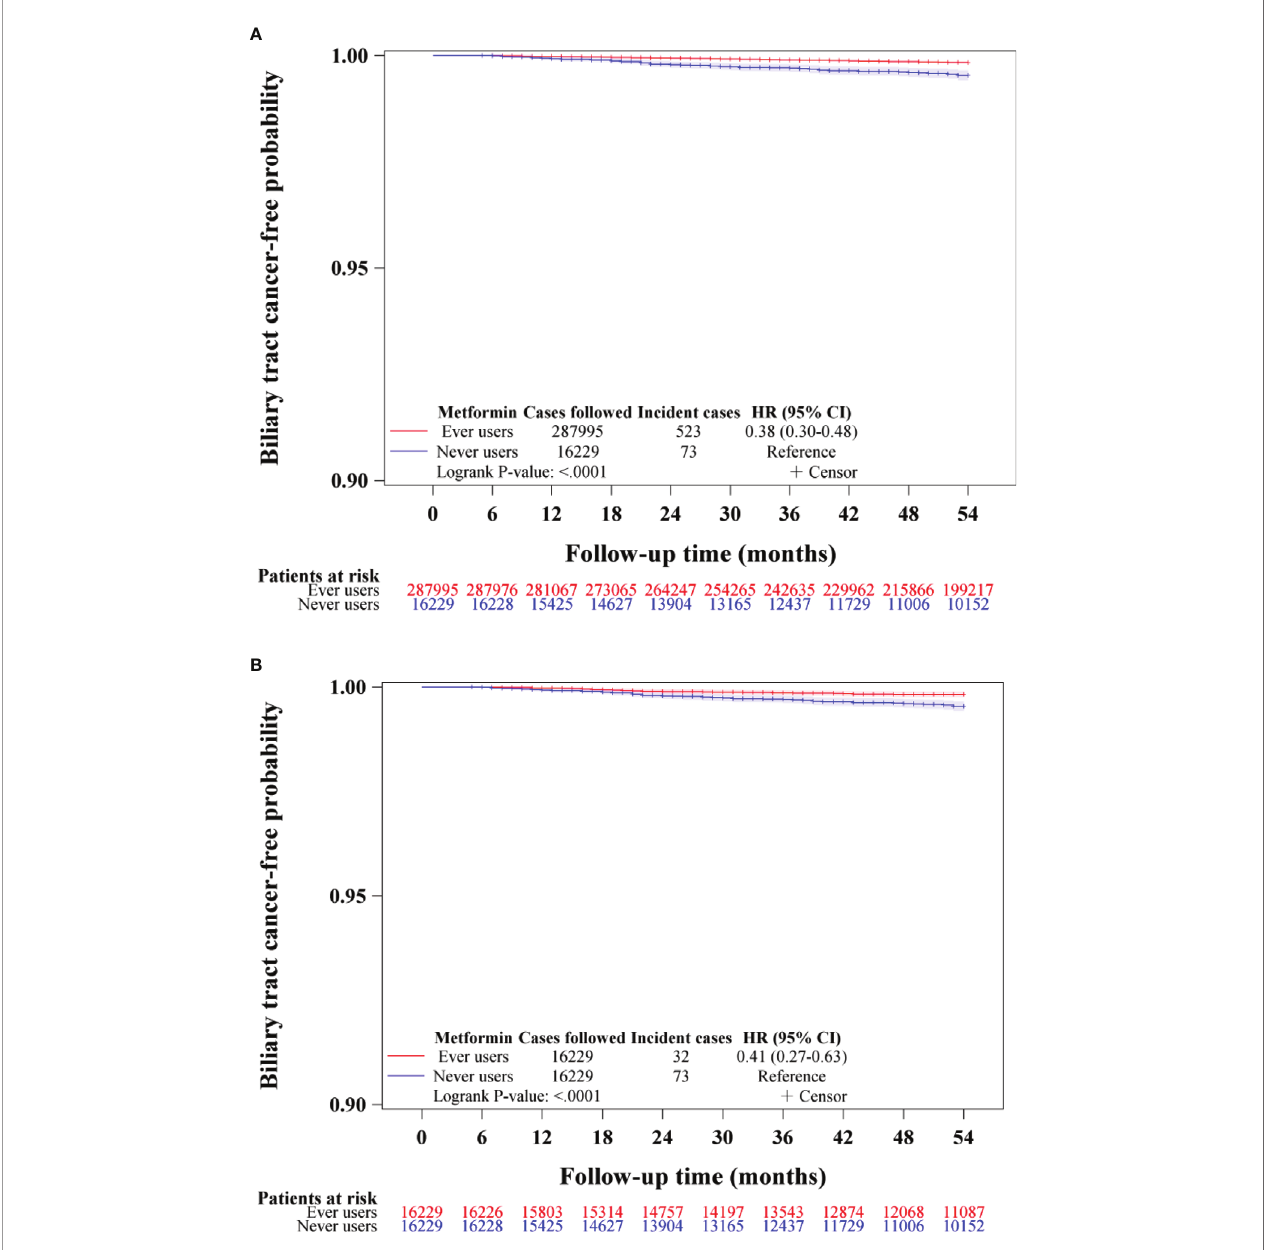
FIGURE 2 | Kaplan-Meier curves for biliary tract cancer-free probability in never and ever users of metformin in the unmatched cohort (A) and matched cohort (B) . HR, hazard ratio; CI, con fi dence